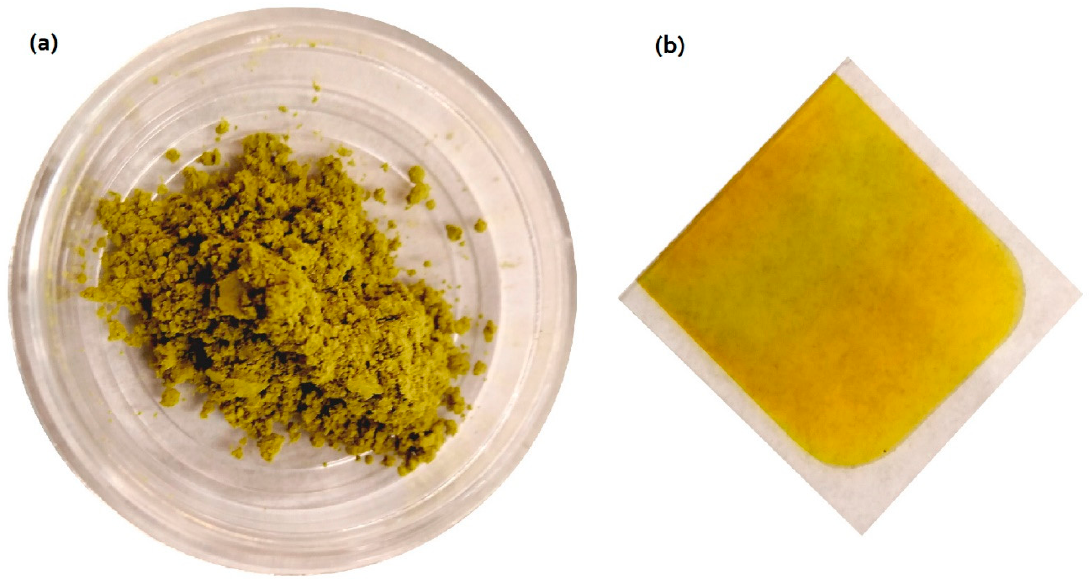
Figure 1. ZnQ 2 -TCNQ semiconductor in ( a ) powder and ( b ) thin film on quartz.